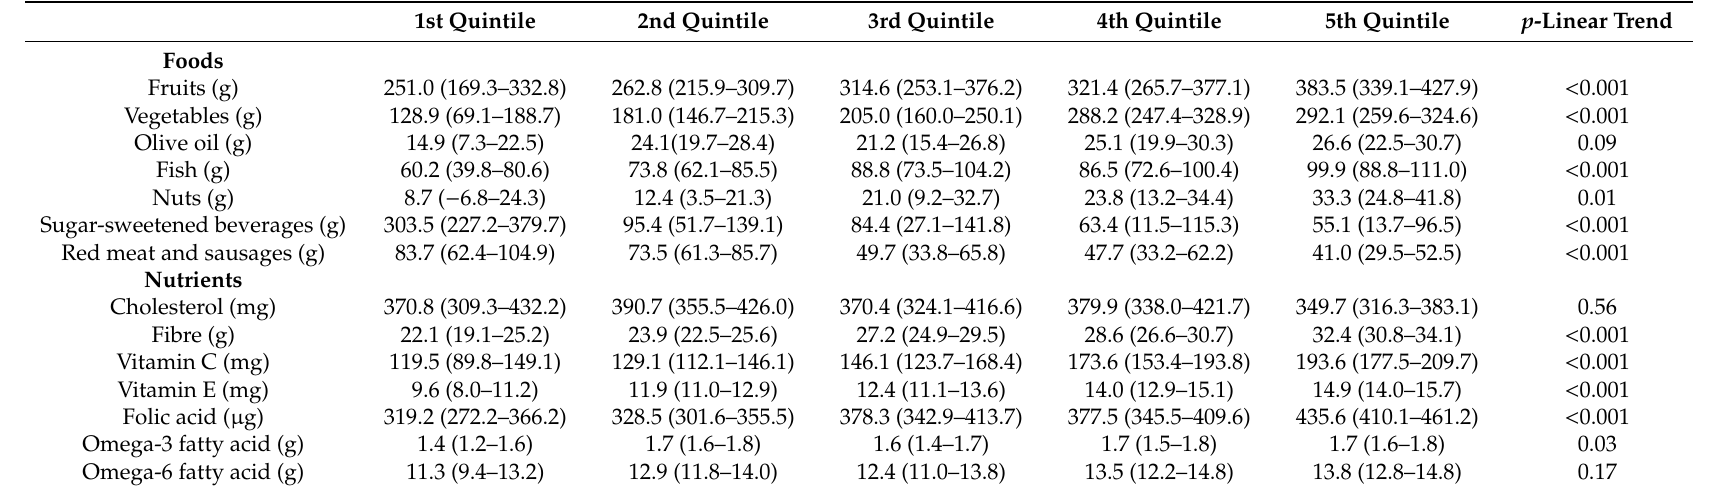
Table 4. Food and nutrient intake recorded on the FFQ according to quintile distribution of MEDAS score administered via face-to-face